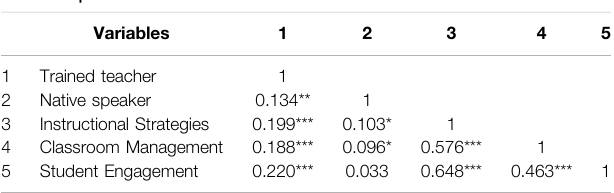
TABLE 5 | Multivariate tests